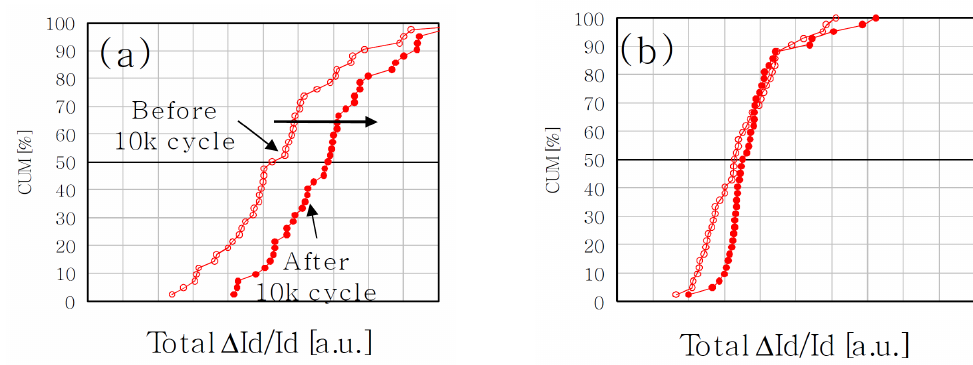
Figure 8. RTN cdf before and after cycling for the case of erased ( a ) and programmed ( b ) cells [110], © 2014,